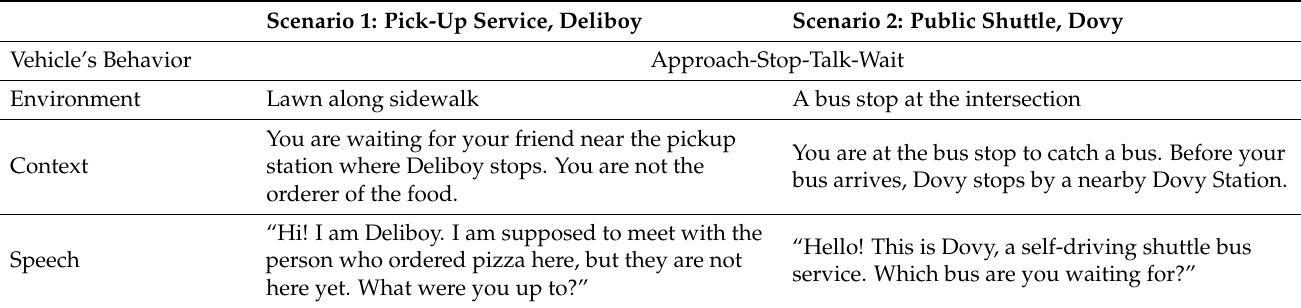
Table 1. Overview of Scenario 1 and Scenario 2.